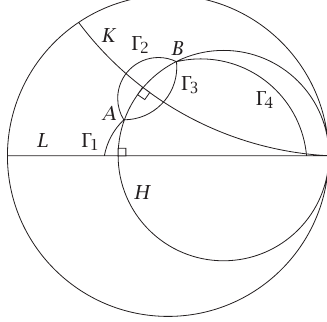
Figure 7.7 . Using a parabolic isometry to show that a nonstandard bubble in H n where each region is connected is